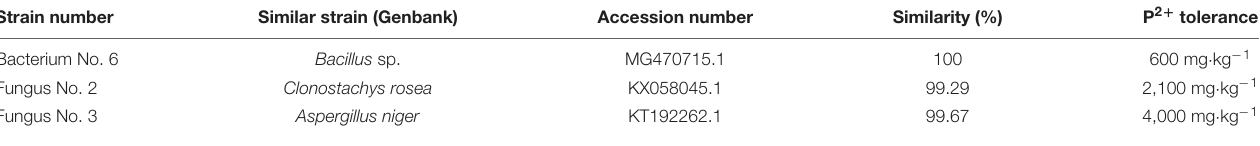
TABLE 1 | Blast results of the inoculation strains in this study. Strain